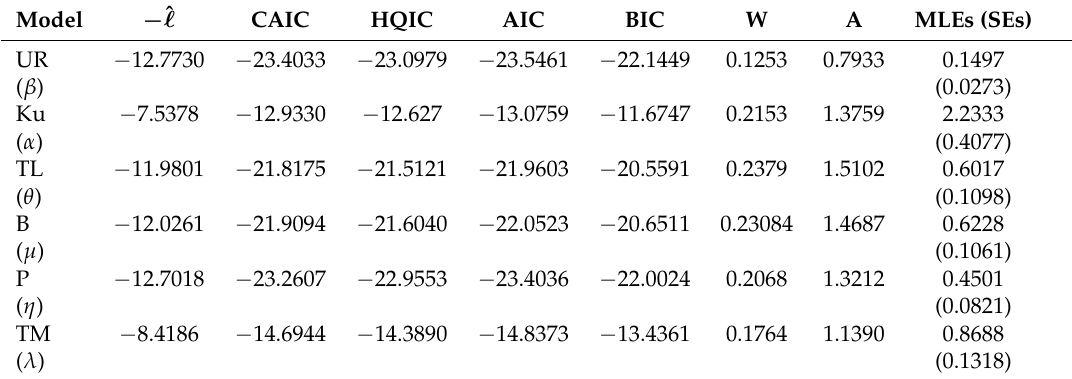
Table 3. Criteria and goodness-of-fit measures, MLEs and SEs for the failure times data set.